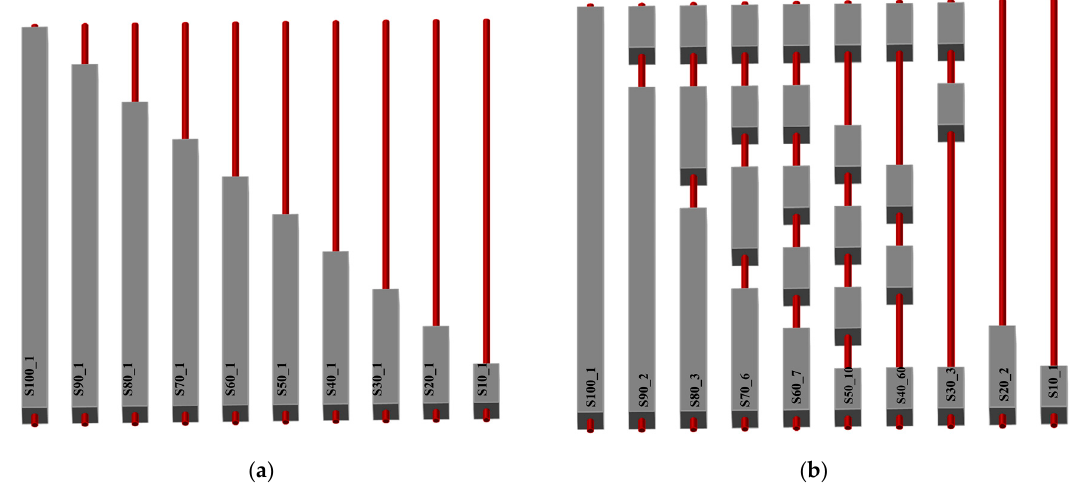
Figure 11. Rock bolt geometrical models: ( a ) Group I and ( b ) Group II.